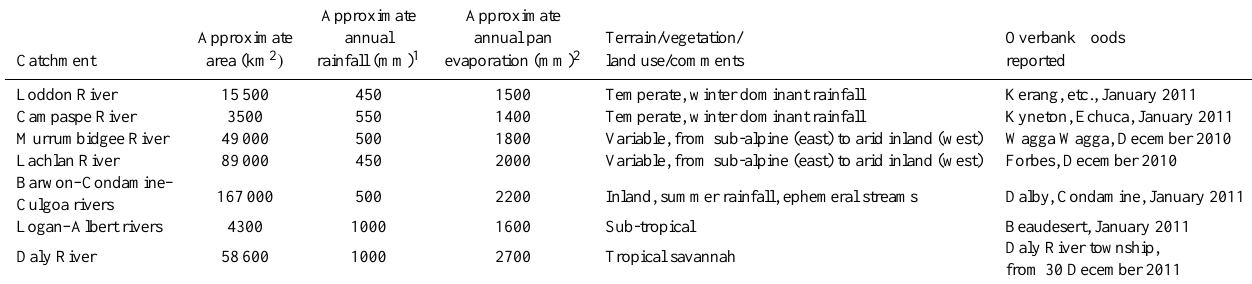
Table 1. Hydrological characteristics of each of the seven catchments used in this